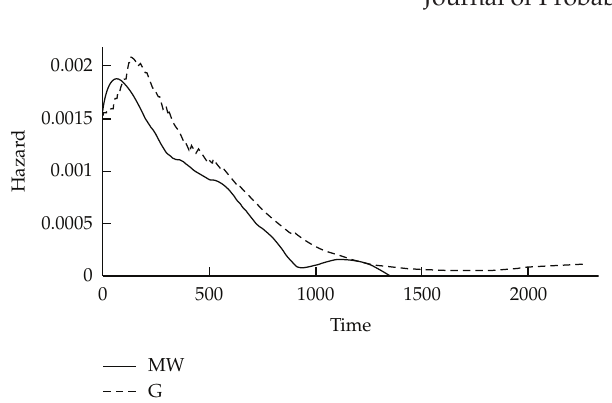
Figure 1: Gamma (cid:3) G (cid:4) and M¨uller and Wang (cid:3) MW (cid:4) estimators of the hazard function for the bone marrow transplant